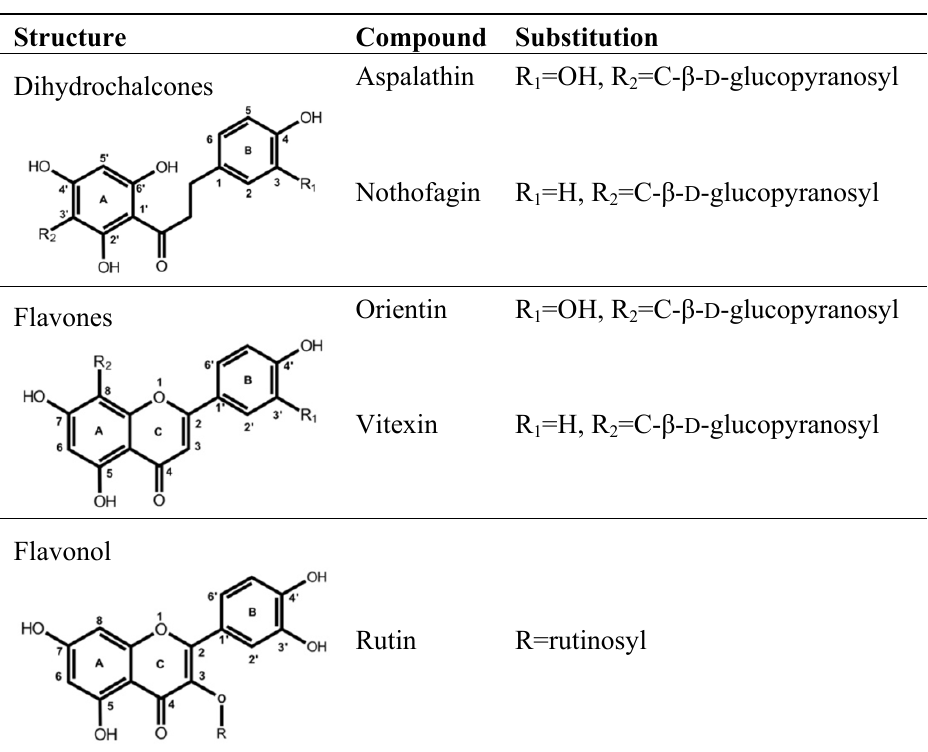
Table 1. Chemical structures of the major rooibos